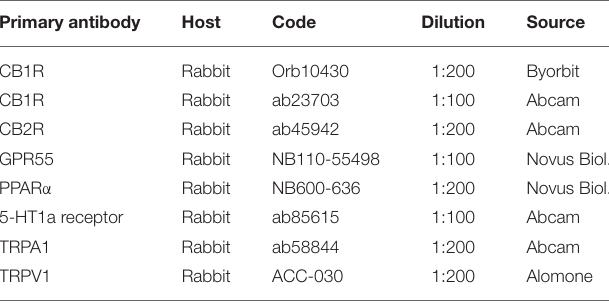
TABLE 3 | Primary antibodies used in the study. Primary